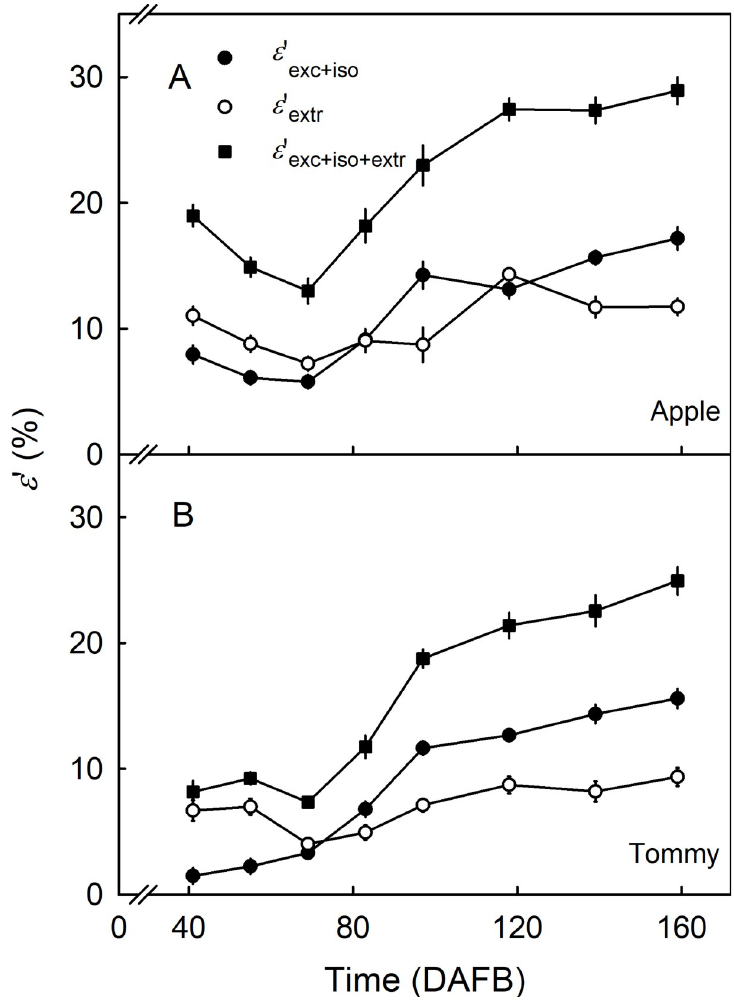
Fig 7. Time course of change in the apparent strain ( ε 0 , %) in the cuticular membrane (CM) of ‘Apple’ (A) and ‘Tommy Atkins’ (B) mango. These strains were quantified as the releases after excision and isolation of the CM ( ε 0 ), after wax extraction ( ε 0 ), and their sum ( ε 0 ). The x-axis scale is in days after full bloom (DAFB). exc þ iso extr exc þ iso þ extr Data represent means ± SE. The number of replicates was 10–20.